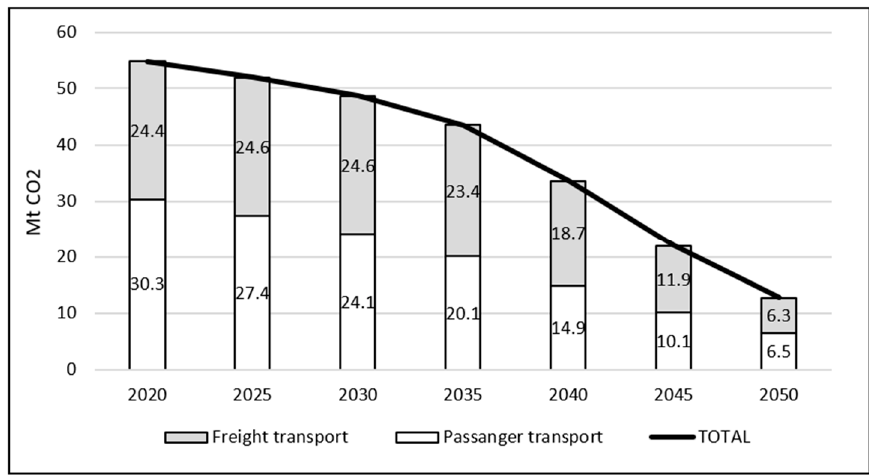
Figure 11. Reduction of CO 2 emissions in Polish road transport (passenger and freight) in the years